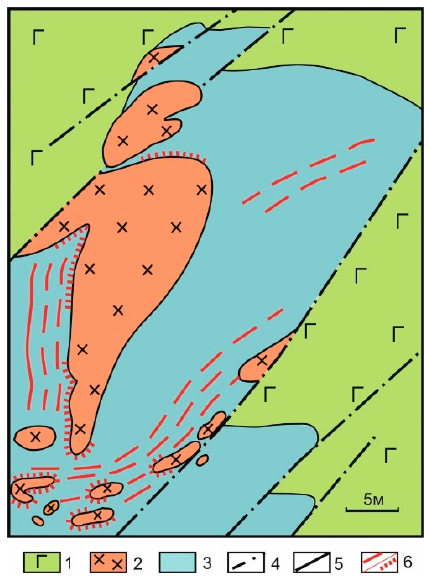
Figure 4. Detailed map of site 3, modified after [19]: 1 = amphibolite after microgabbro; 2 = nepheline syenite; 3 = brucite marble; 4 = ductile faults; 5 = contacts; 6 = calc–silicate veins and contact skarn. The skarns comprise two zones between nepheline syenite and brucite marble: nepheline–pyroxene with phlogopite (i) and forsterite–spinel with phlogopite (ii). A large part of skarns are banded